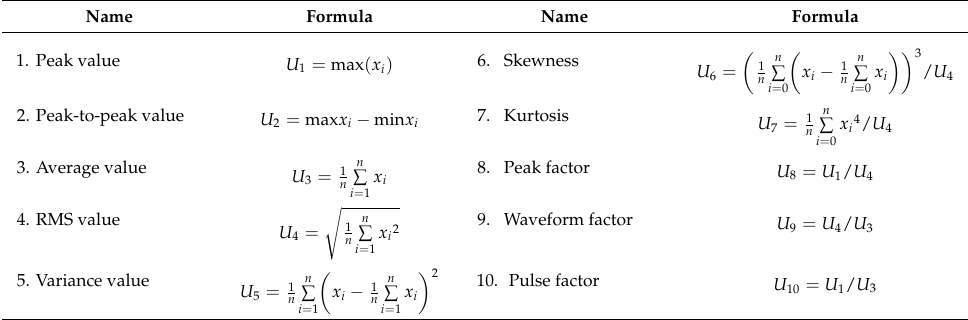
Table 2. Time domain feature name and